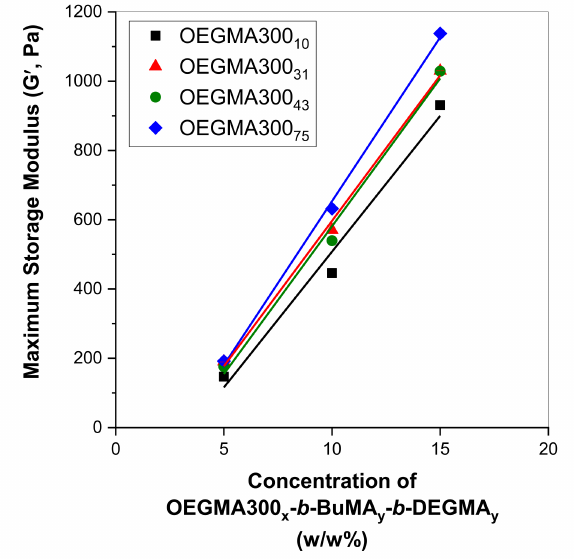
Figure 4. Maximum storage modulus (G’) as a function of the concentration of the triblock terpolymer, in mixtures with OEGMA300 x homopolymers. The total concentration was kept at 20 w/w % in phosphate buffered saline (PBS). The degree of polymerisation of the OEGMA300 x homopolymers was varied from 10 (black squares), to 31 (red triangles), to 43 (green circles), to 75 (blue rhombi). The data were fit with linear